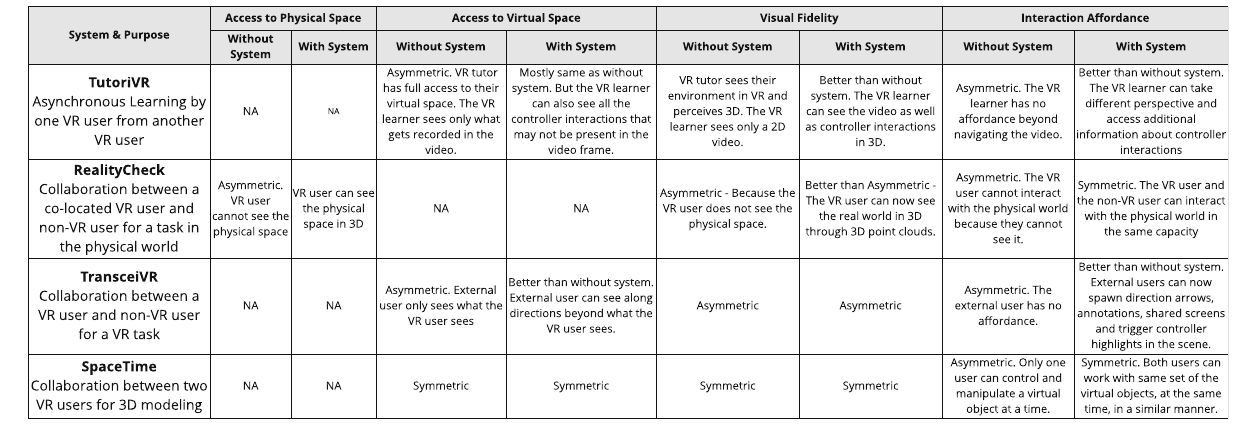
FIGURE 6 | Sources of xspace asymmetry addressed by select by systems in select prior works.